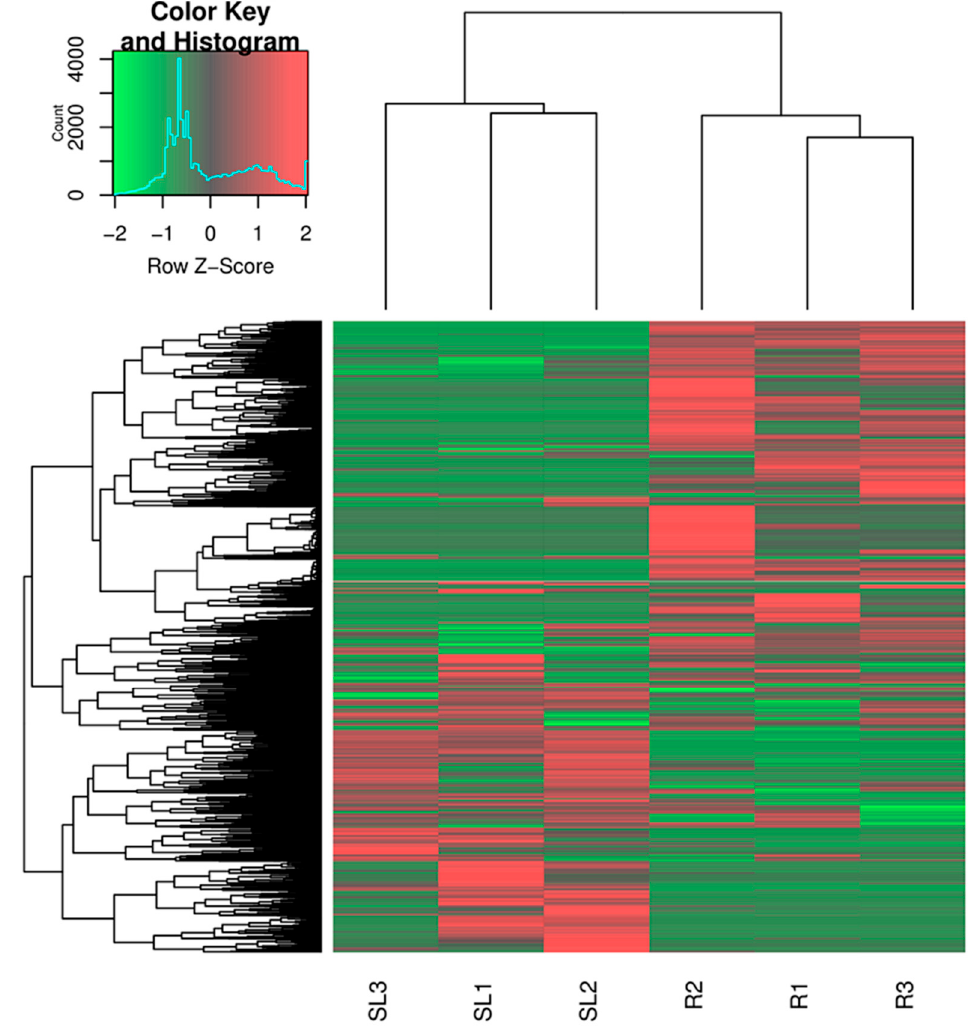
Figure 1. Heat map of gene expression level of the roots (R) samples and a mixture sample of stems and leaves (SL) of R . yunnanensis .